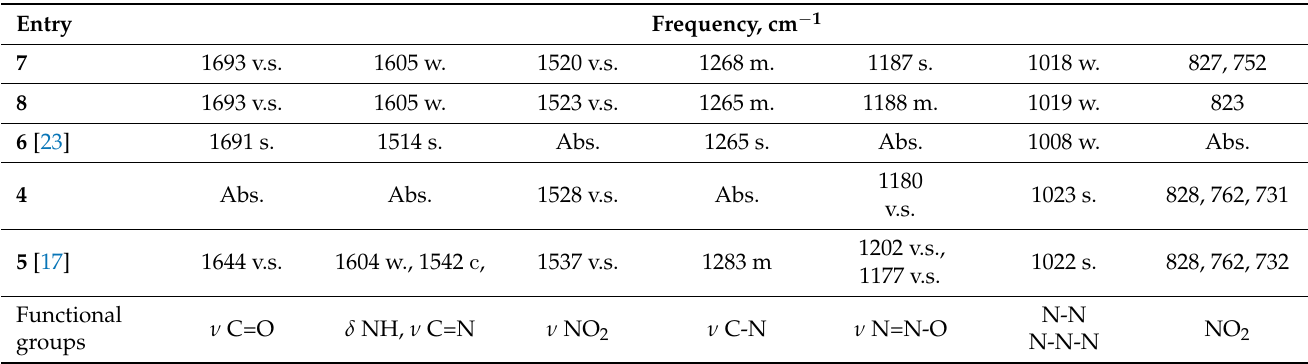
Table 1. Comparative basic IR frequencies of 4 , 5 , 6 , 7 , and 8 .